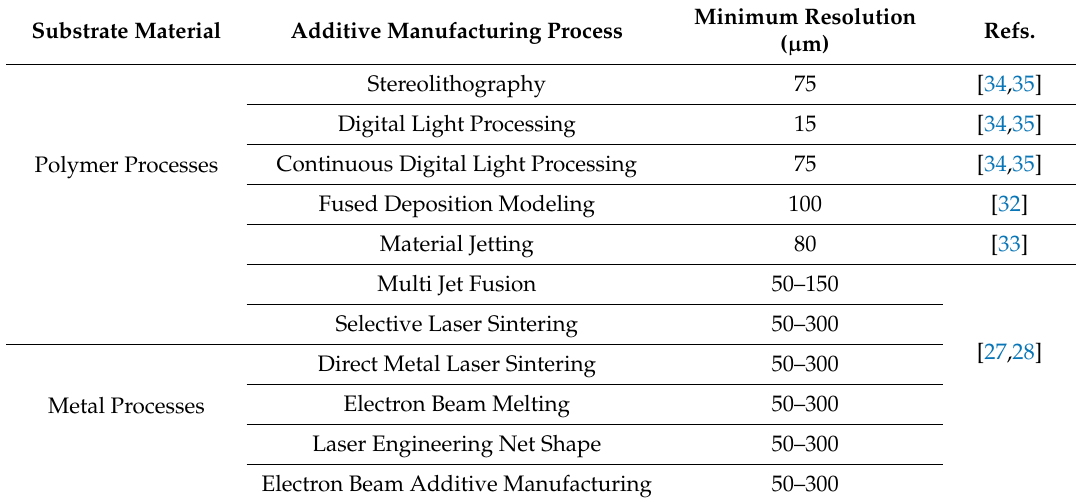
Table 3. Commercial additive manufacturing processes and resolution